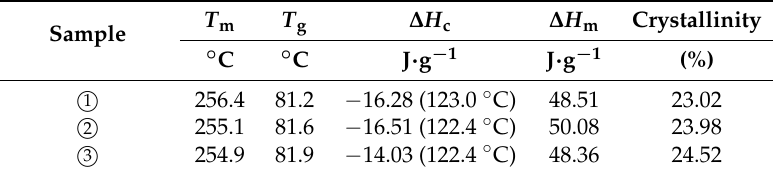
Table 3. Thermodynamic properties of PET